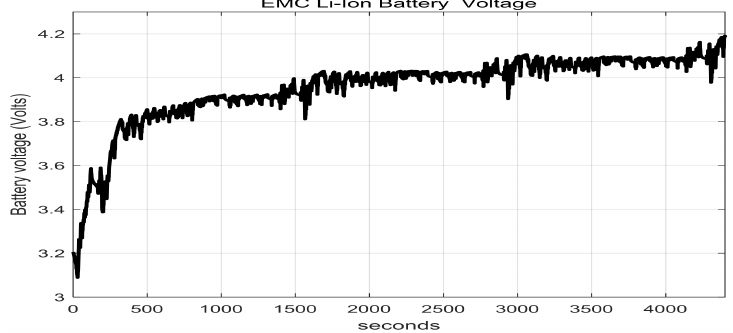
Figure 16. The 2RC EMC Li-Ion battery terminal voltage for three UDDS cycles charging current profile test.